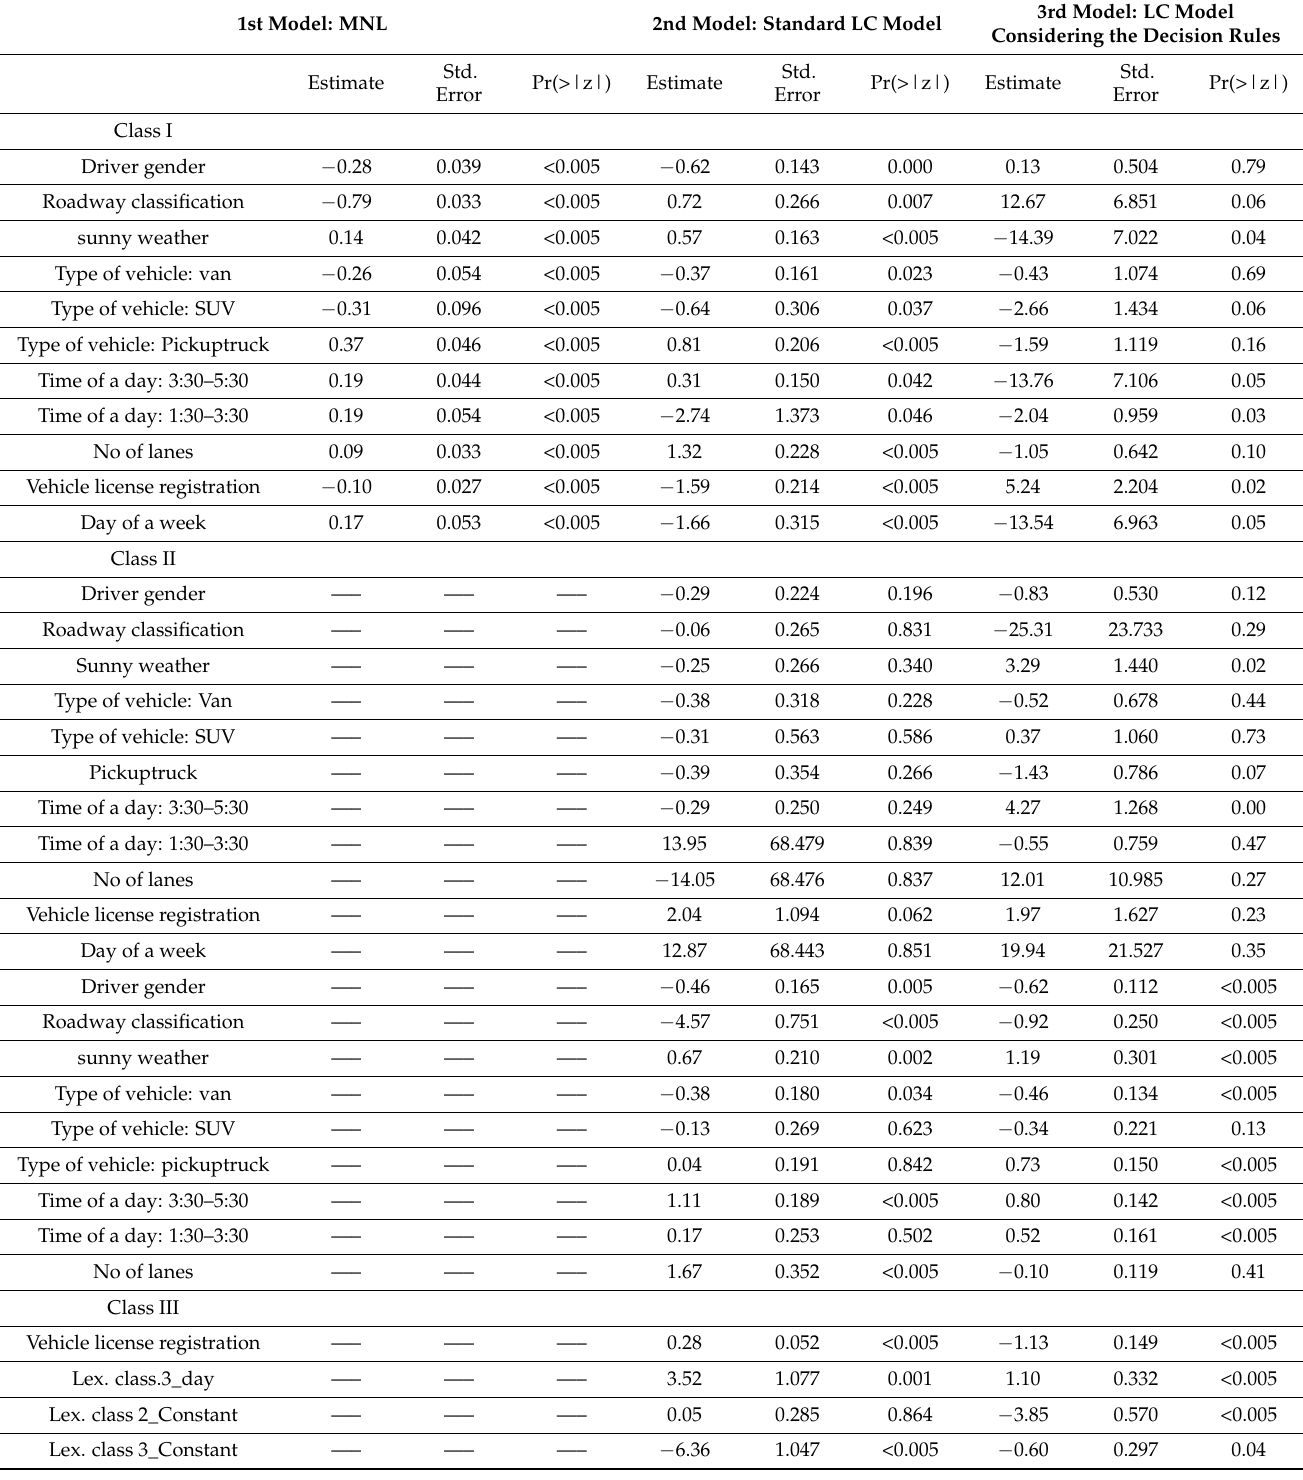
Table 2. The results of the considered models. MNL: multinomial logit; LC: latent class; BIC: Bayesian information criterion. 1st Model: